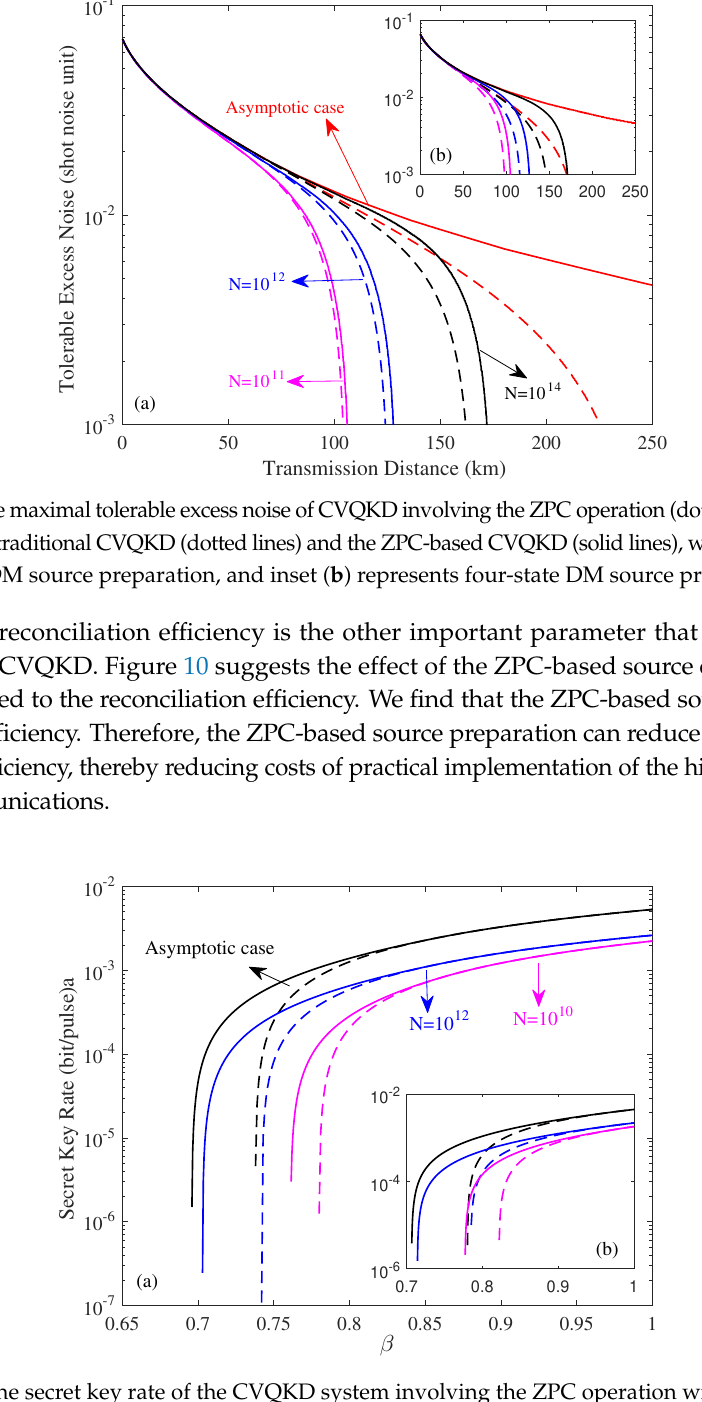
Figure 10. The secret key rate of the CVQKD system involving the ZPC operation with L = 50 km and ε = 0.01 for the traditional CVQKD system (dotted lines) and the ZPC-based CVQKD system (solid lines), where ( a ) represents eight-state DM source preparation, and inset ( b ) represents four-state DM source